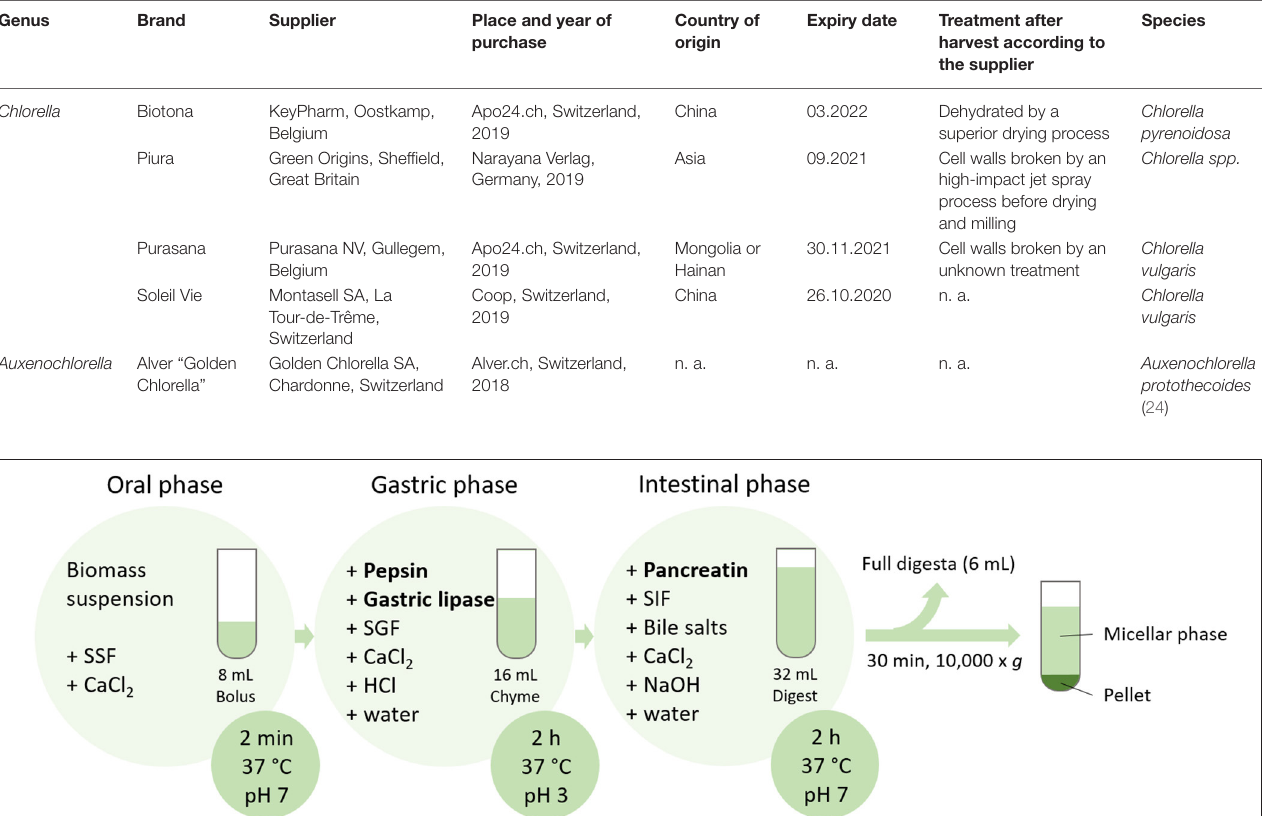
TABLE 1 | Overview of the powdered Chlorella and Auxenochlorella biomasses. Genus